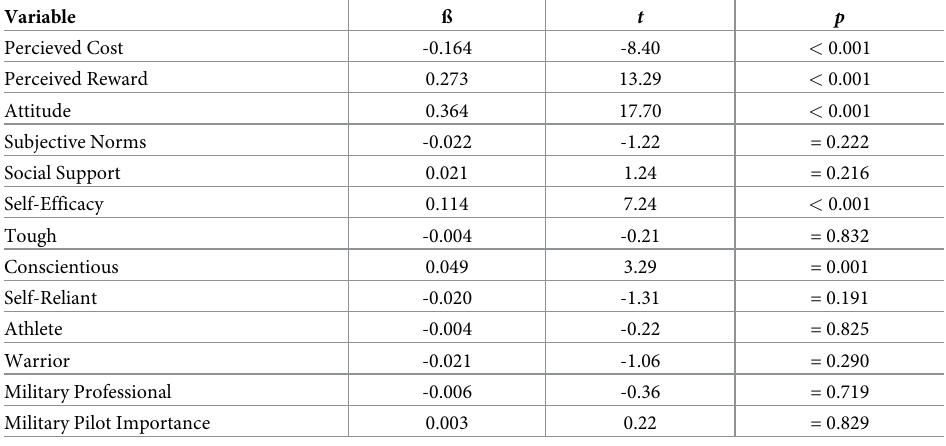
Table 2. Regression using the following variables as simultaneous predictors of anticipated concussion disclosure.